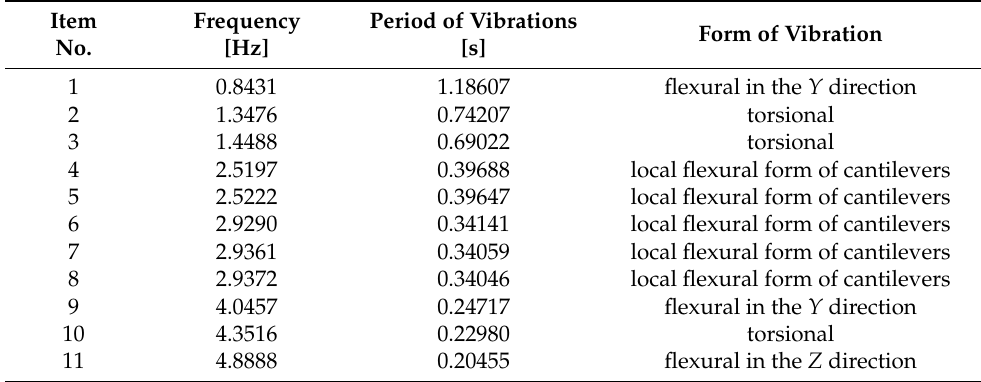
Table 6. The compilation of dynamic characteristics of